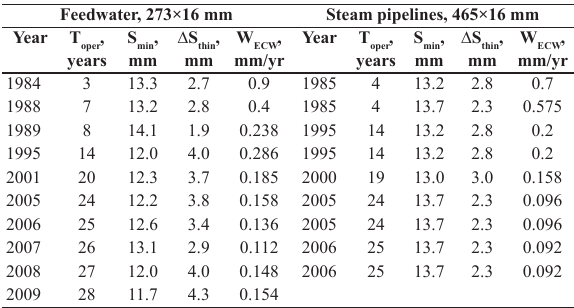
Table 2. Values of thinning and ECW rate of the feedwater pipe- line and steam pipeline at NPPs with VVER-440 in different operating periods.